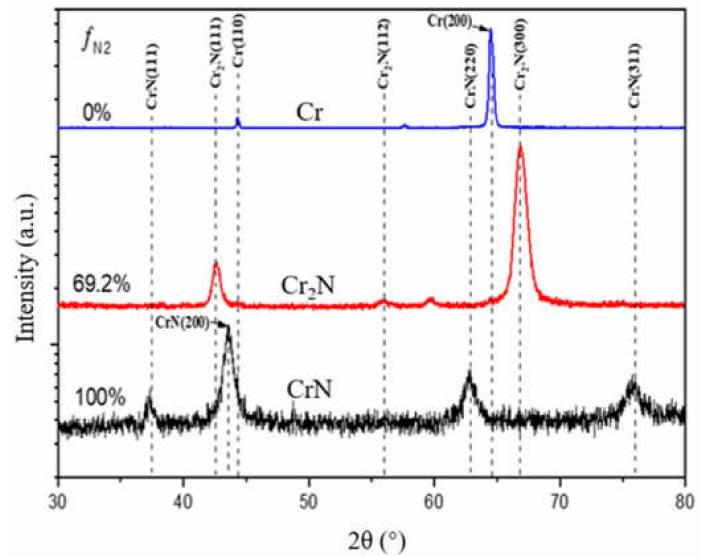
Figure 3. XRD patterns of the Cr-N x